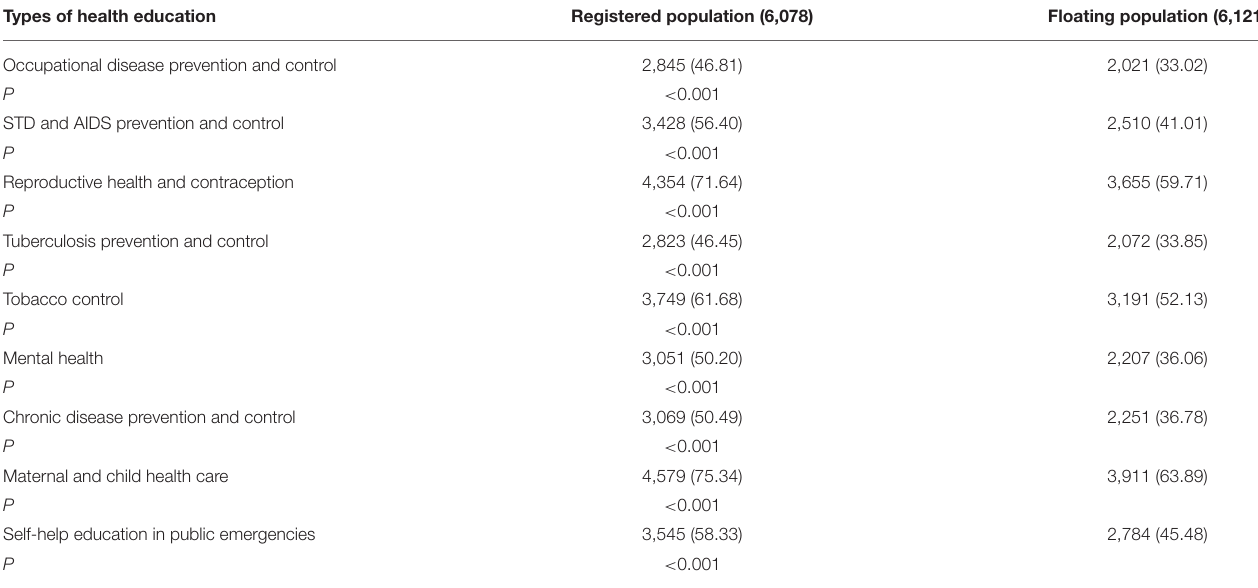
TABLE 2 | Comparison of health education utilization between registered residence population and floating